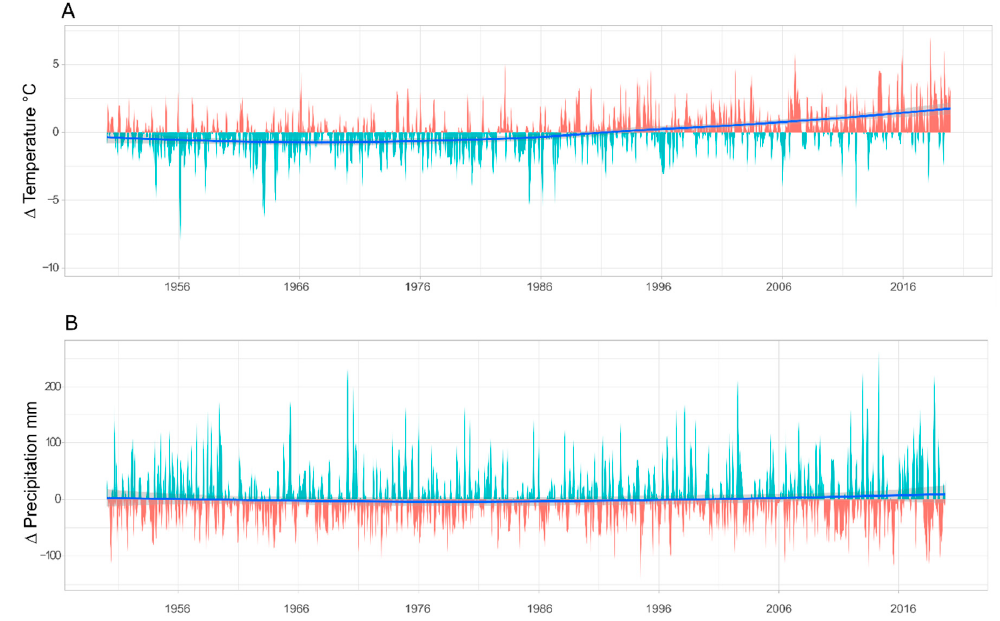
Figure 3. Reconstructed monthly anomalies of ( A ) temperature and ( B ) precipitation relative to the years 1961 to 1990 at LTER Zöbelboden. The blue solid lines represent the long-term trend and their confidence interval using a loess smoother.